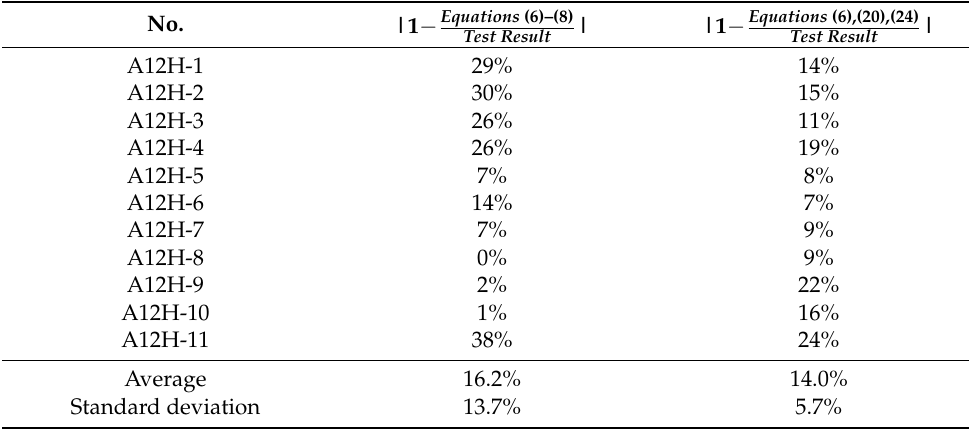
Table 6. Error rate comparisons between design